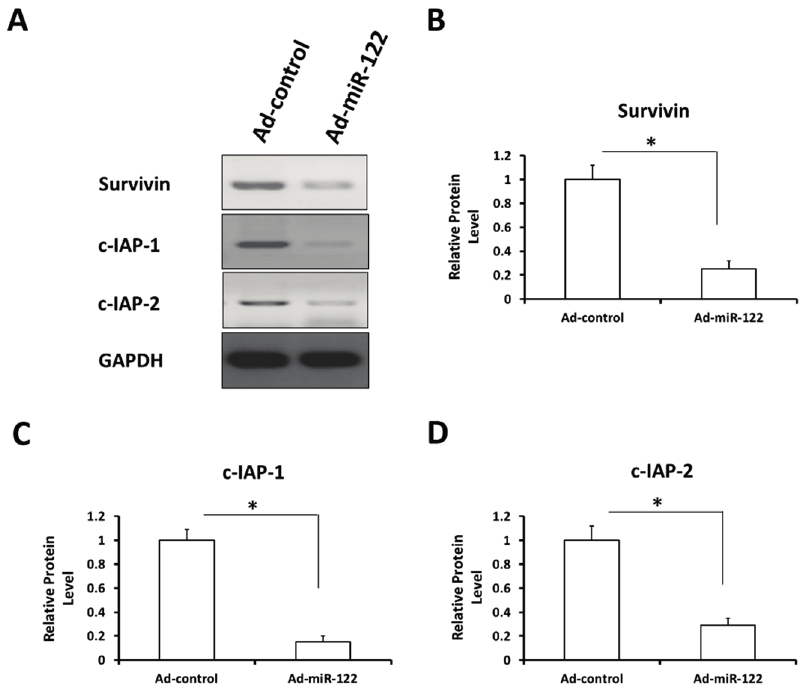
Figure 6. MiR-122 represses the expression of Survivin, c-IAP-1 and c-IAP-2 in A549 cells. ( A ) A549 cells, which were infected with Ad-control or Ad-miR-122, were then harvested for Western blot. The expression of Survivin, c-IAP-1 and c-IAP-2 were detected by anti-Survivin, anti-cIAP1 or anti-cIAP2 antibodies. GAPDH was chosen as the loading control; ( B – D ) Relative protein level was shown as mean ± SD from triple experiments with similar results. * p < 0.05 versus Ad-control or